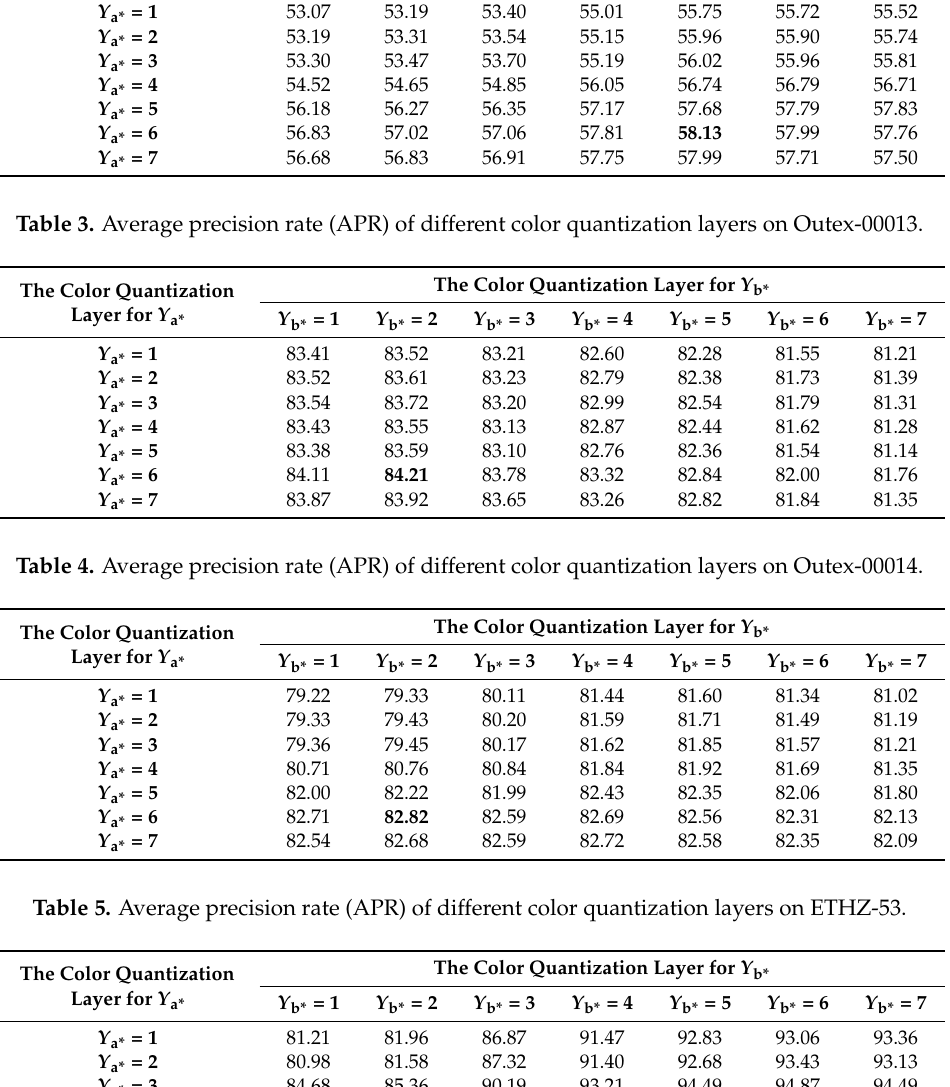
Table 2. Average precision rate (APR) of different color quantization layers on AID. The Color Quantization Layer for Y a*